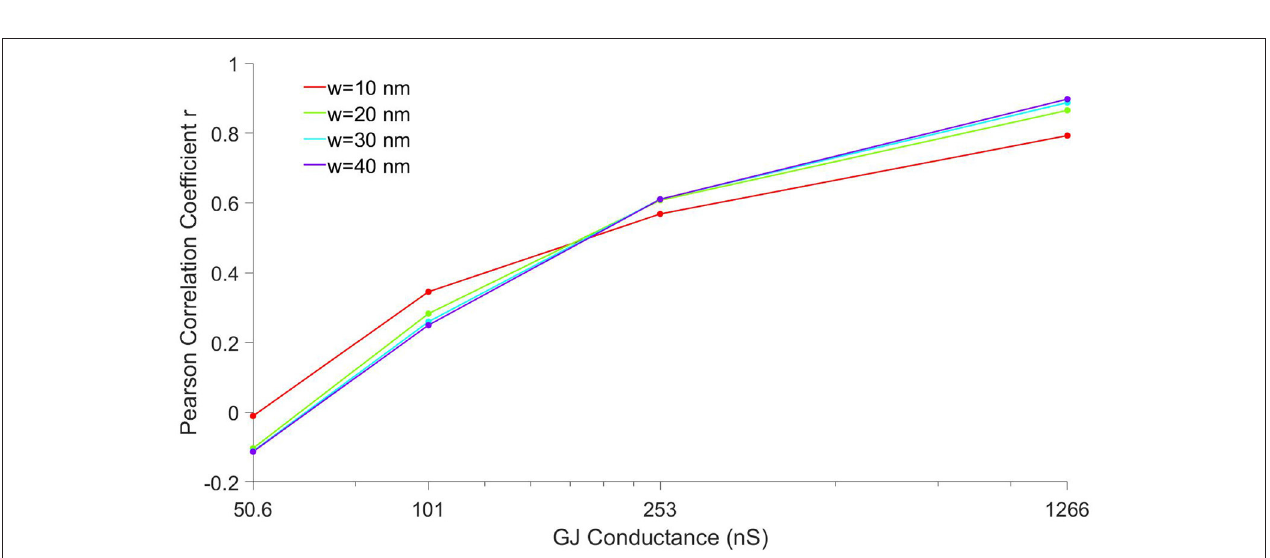
FIGURE 5 | Correlation between conduction velocity (CV) and total cell Na + conductance depends on gap junctional coupling. The Pearson correlation coefficient r between CV and total cell Na + conductance ( G Na ) is shown as a function of GJ coupling conductance, for four different cleft width w values.